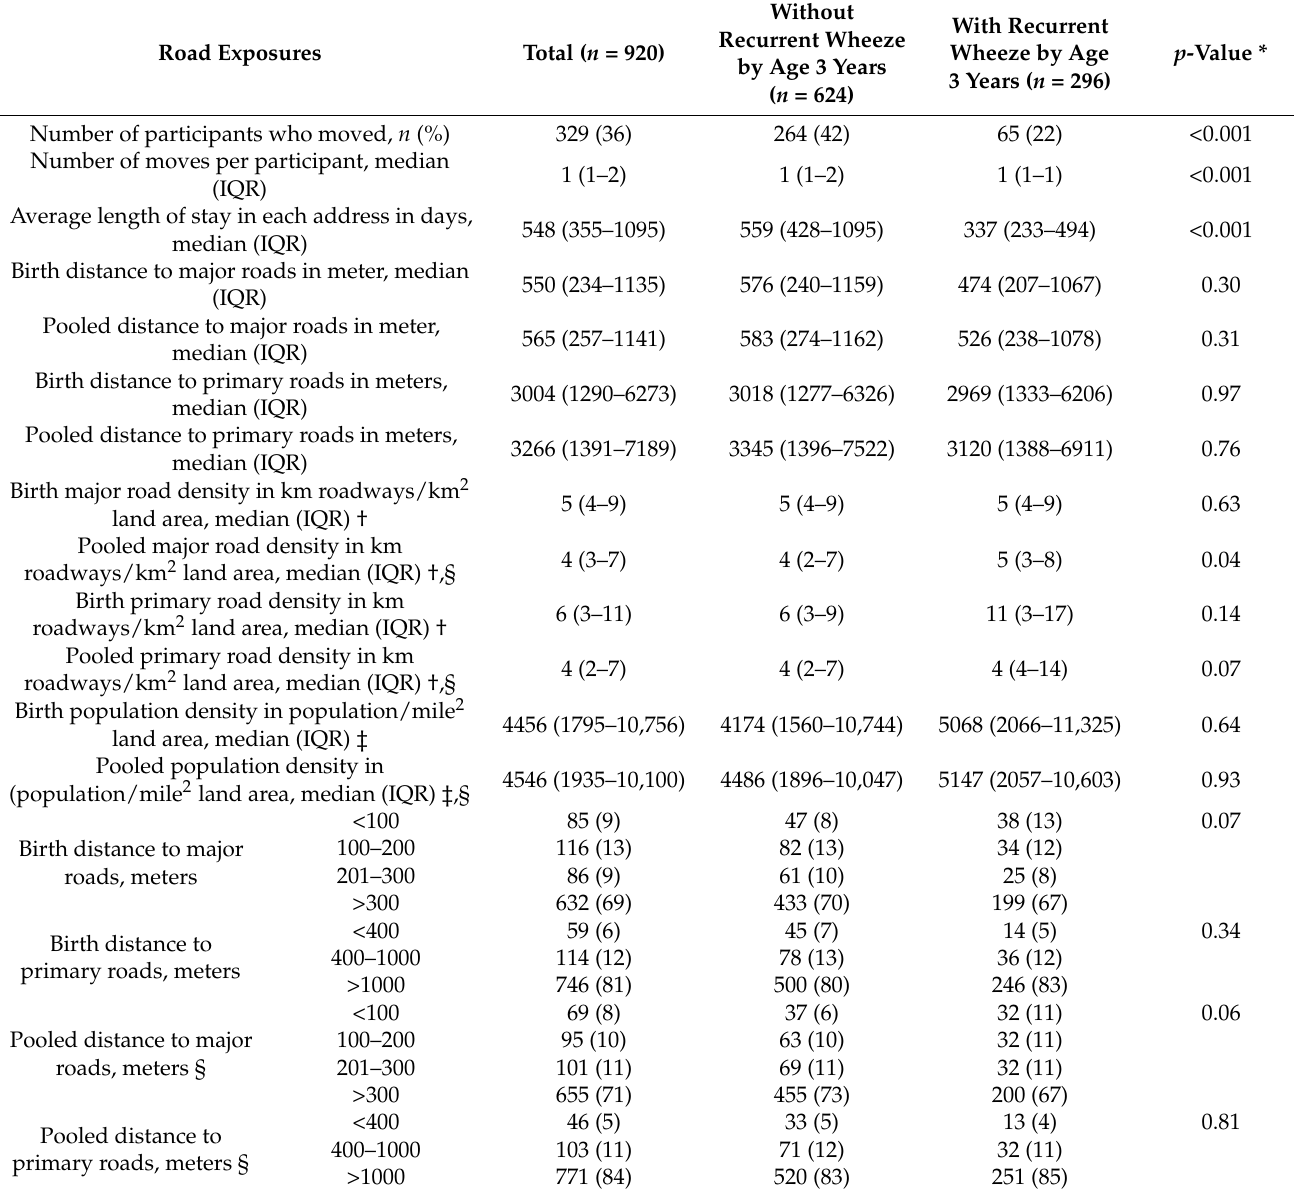
Table 3. Distribution of road exposures at birth and pooled road exposures by recurrent wheeze status by age 3 years.